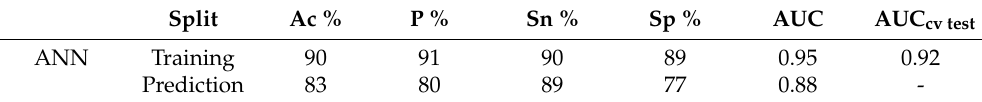
Table 4. Quality indicators calculated for the training set and for the prediction set. Split Ac % P % Sn % Sp % AUC